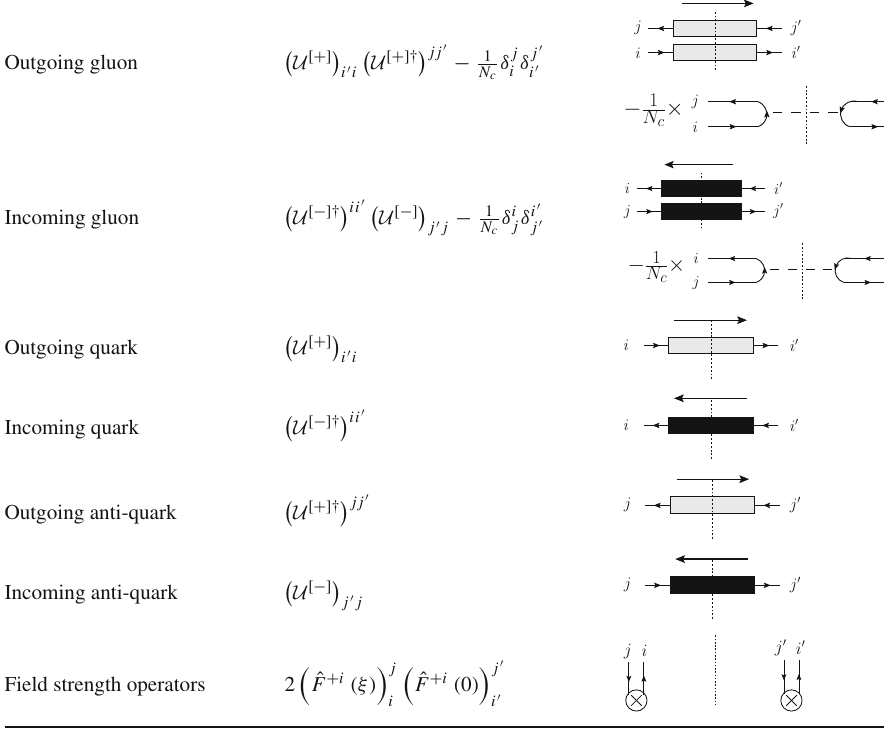
Table 2 Color flow Feynman rules for the gauge links. The diagrams correspond to the cut lines, as denoted by the vertical dotted line. The routing in the color loops is